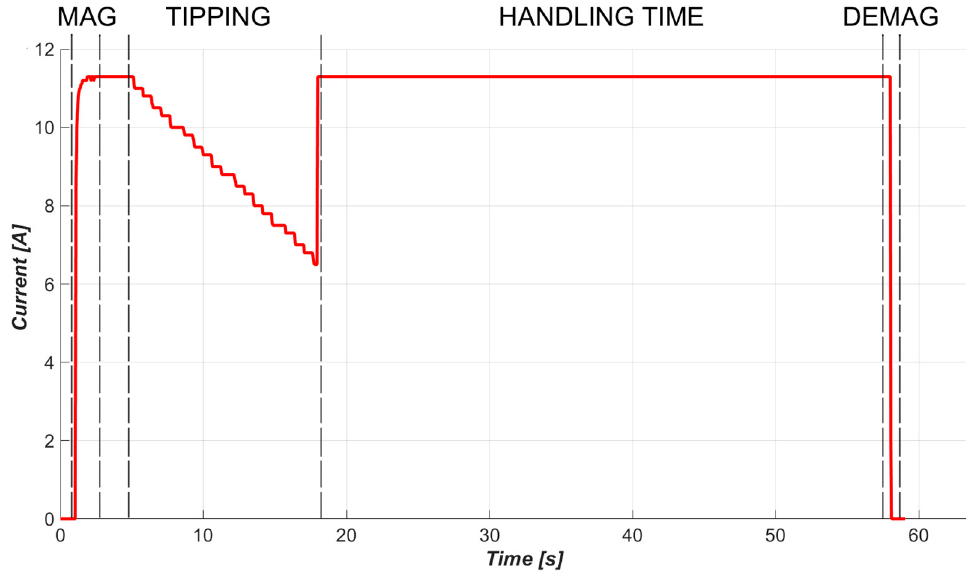
Figure 10. The Case 1 current trend for a complete cycle of the EM system.